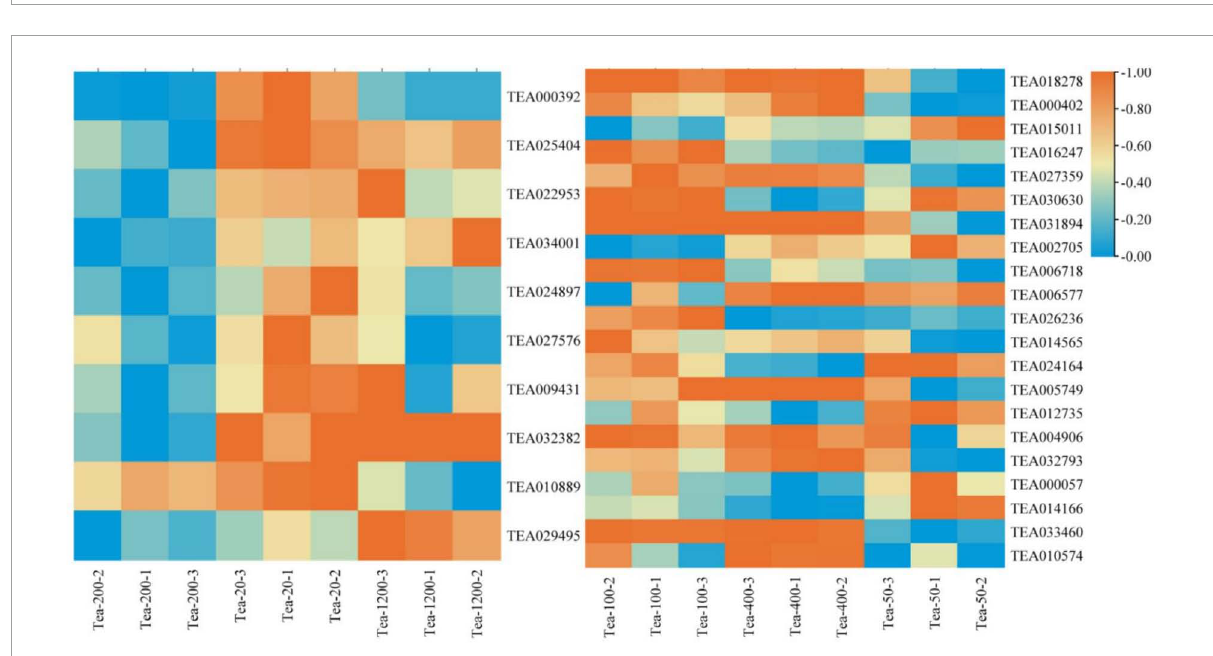
FIGURE6 Heat map of the phenylpropane biosynthesis pathway and related gene expression in tea shoots of different years. The left heat map for Group JP, and the right heat map for Group